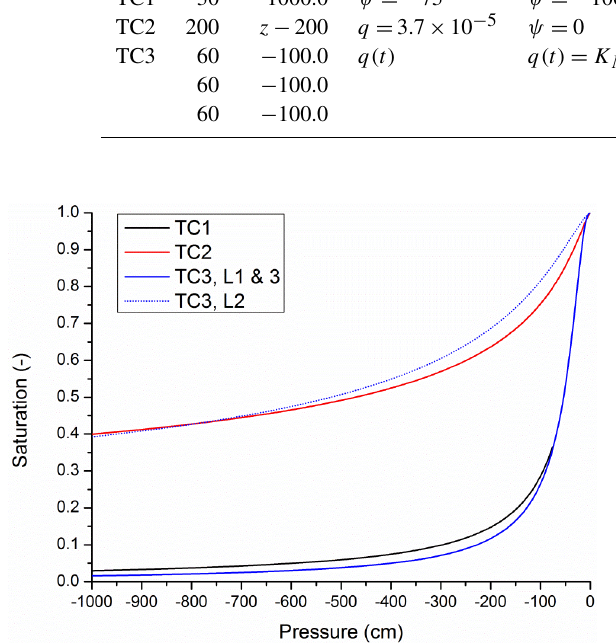
Figure 3. Specific moisture capacity as a function of the pressure for the three test cases (L1, L2 and L3 are the three layers for test case